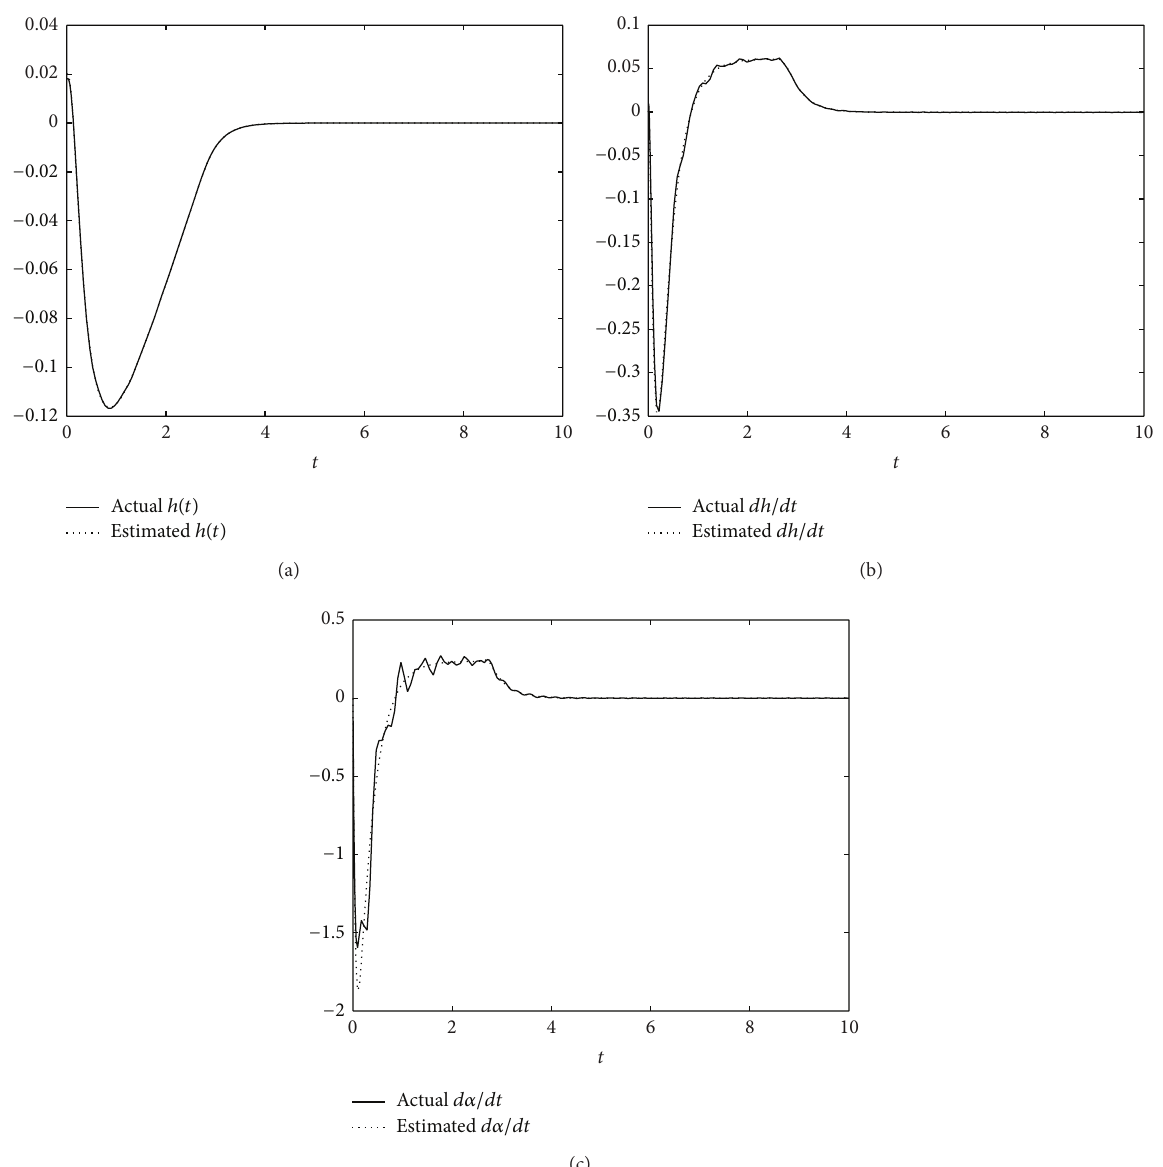
Figure 3: Performance of the estimator as a function of time: (a) ℎ(𝑡) ; (b) 𝑑ℎ/𝑑𝑡 ; (c) 𝑑𝛼/𝑑𝑡